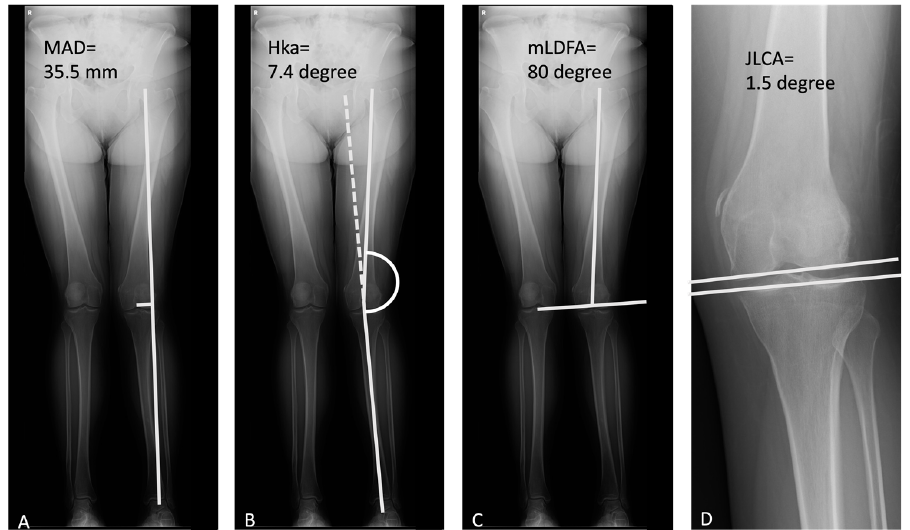
Figure 1. Radiographic parameters: ( A ) mechanical axis deviation, MAD (35.5 mm), ( B ) hip–knee angle, HKa (7.4 degree), ( C ) mechanical lateral distal femoral angle, mLDFA (80 degree), ( D ) joint line congruency angle, JLCA (1.5 degree).